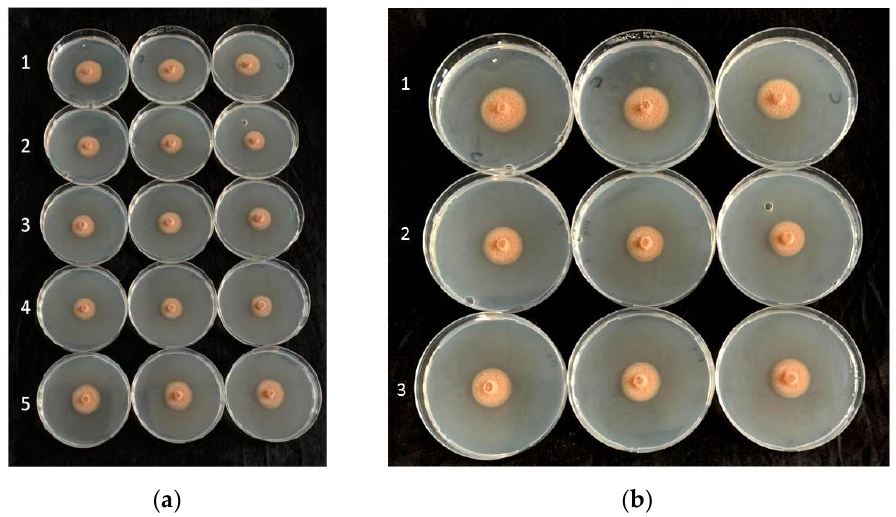
Figure 2. ( a ) Activity of bacterial filtrates against Plenodomus tracheiphilus isolate PT6: 1, control plates; 2, Bacillus amyloliquefaciens QST713 (formerly B. subtilis ; Serenade ® ); 3, B. amyloliquefaciens strain D747 (Amylo-X ® ); 4, B. amyloliquefaciens MBI600 (Serifel ® ); 5, B. amyloliquefaciens FZB24 (Taegro ® ). ( b ) Detail of bacterial filtrate activity against pathogen: 1, control plates; 2, B. amyloliquefaciens QST713 (former B. subtilis ; Serenade ® ); 3, B. amyloliquefaciens strain D747 (Amylo-X ® ).